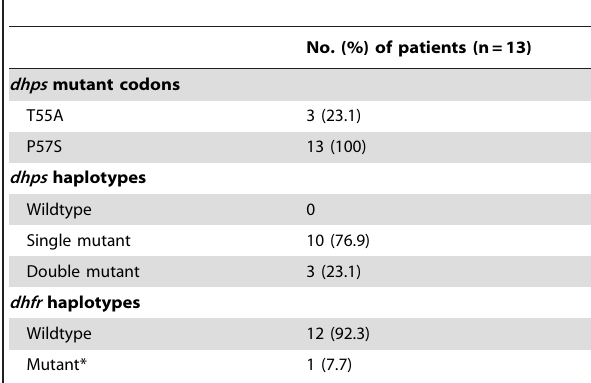
Table 1. Prevalence of P. jirovecii